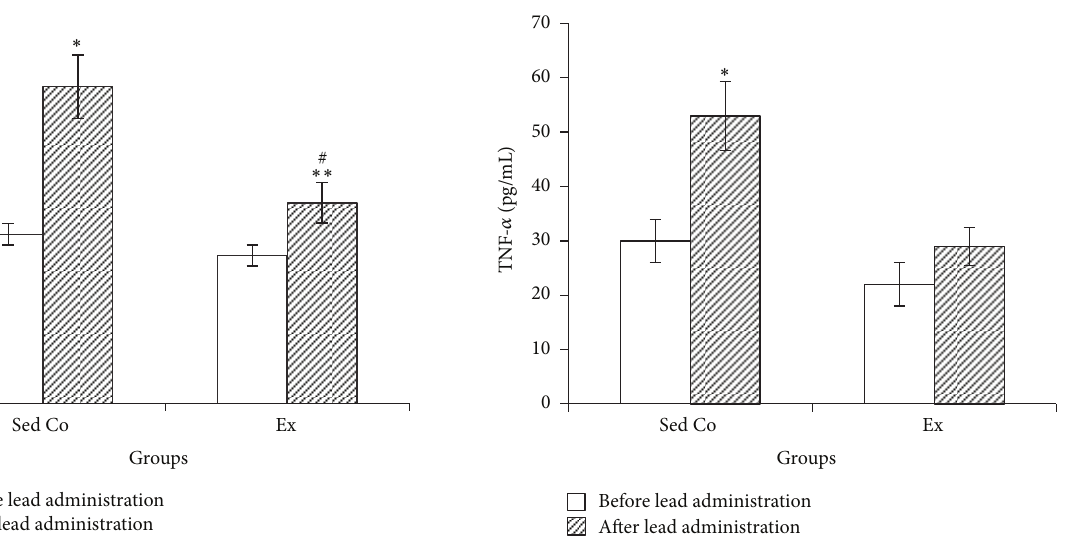
Figure 5: Plasma tumor necrosis factor- 𝛼 in sedentary control and exercise groups before and after lead administrations. Seven days of lead injections (15mg/Kg body weight, ip) to sedentary animals housed in the regular cages caused significant increase of plasma TNF- 𝛼 ( ∗ 𝑃 < 0.05 compared to the “before lead administration”); in Ex animals housed in the wheel equipped cages, plasma TNF- 𝛼 changes after the same dose lead administrations were not significant. The data are presented as means ± S.E.M. TNF- 𝛼 : tumor necrosis factor- 𝛼 ; Sed Co: sedentary control group; Ex: exercise